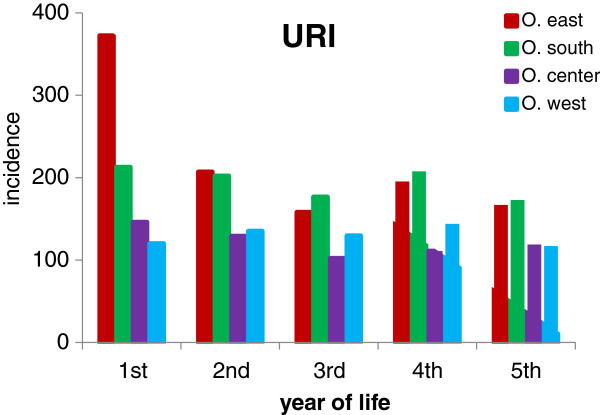
Incidence of upper respiratory infections (URI) per 100 children per year of life. Numbers of children stratified by age and region of residence are presented in Table 3.